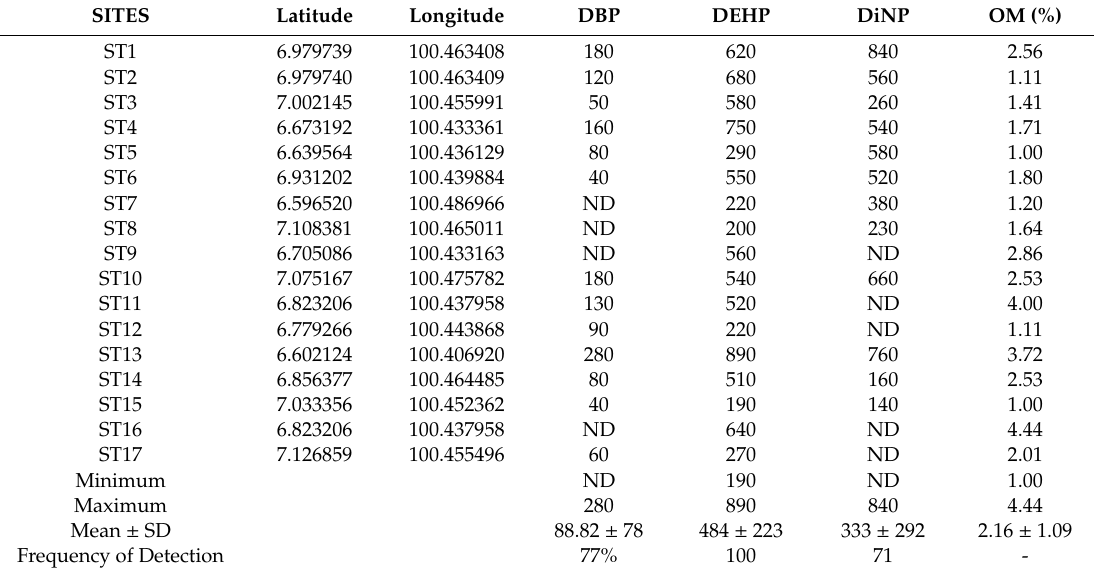
Table 2. Concentrations of PAEs and organic matter OM in sediments from U-Tapao canal (ng / g dw).